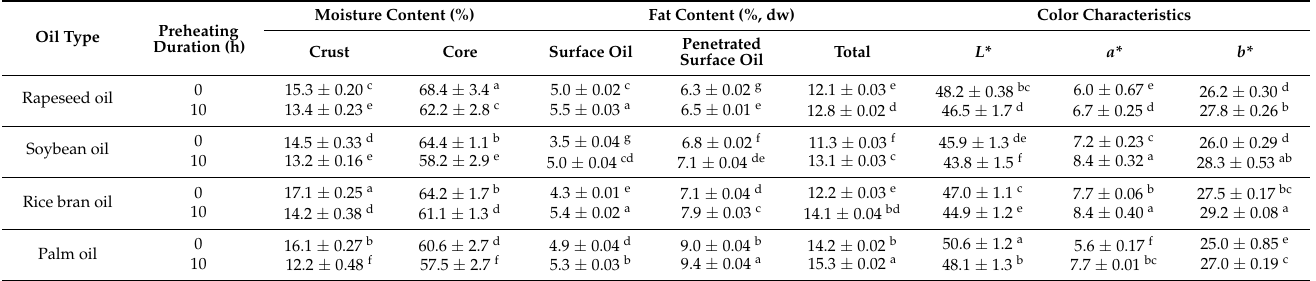
Table 2. Moisture and fat contents and color characteristics of fried BBFNs using fresh and pre- heated oils